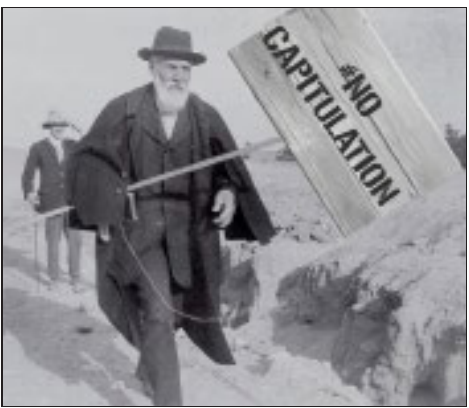
Figure 7: Photograph of Flinders Petrie edited to express support for the USS pension strikes held in 2018. (Photo: Archaeology on Strike